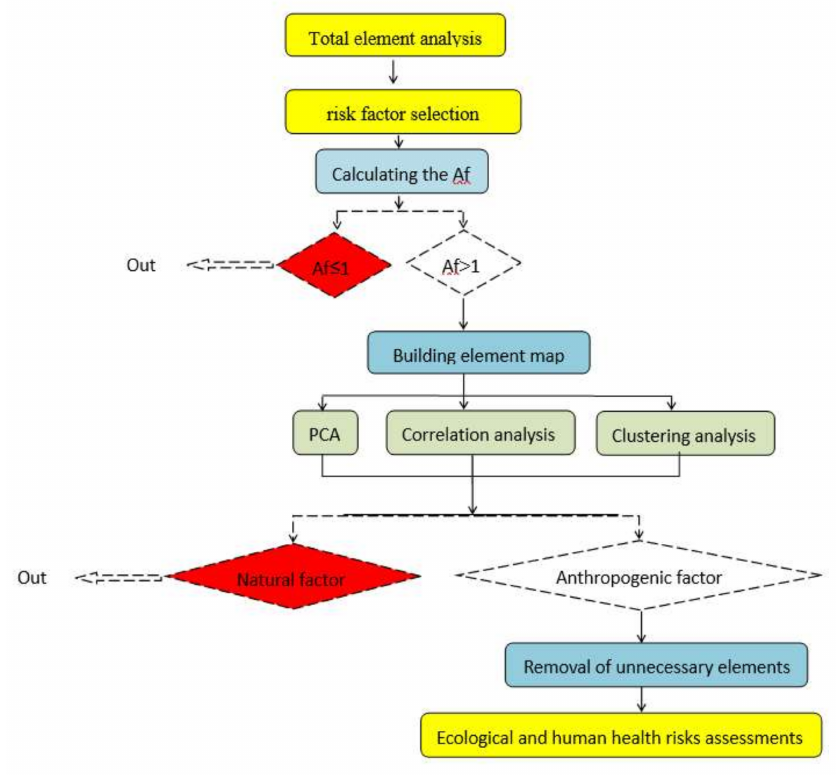
Figure 2. Framework for the health risk assessment